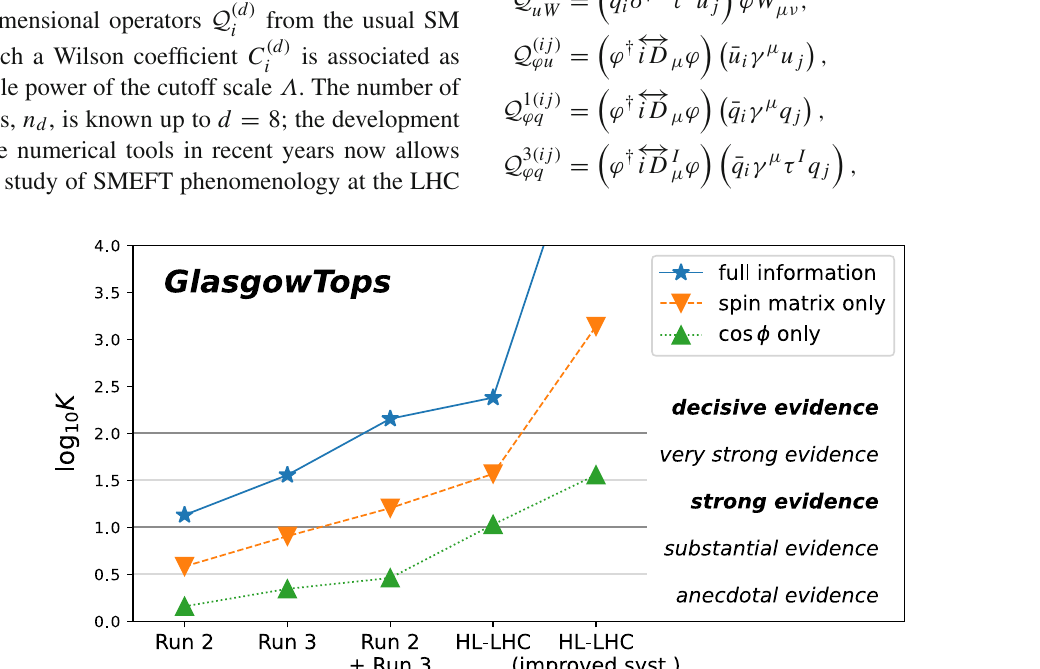
( d ) from the usual SM i